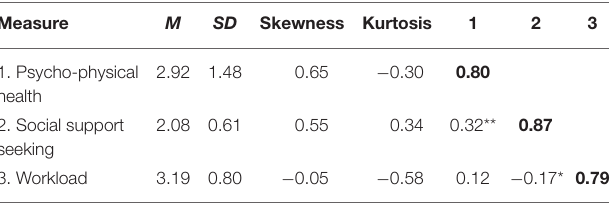
TABLE 2 | Descriptive, internal consistency, and intercorrelations for study variables among non-affected workers ( N = 173).